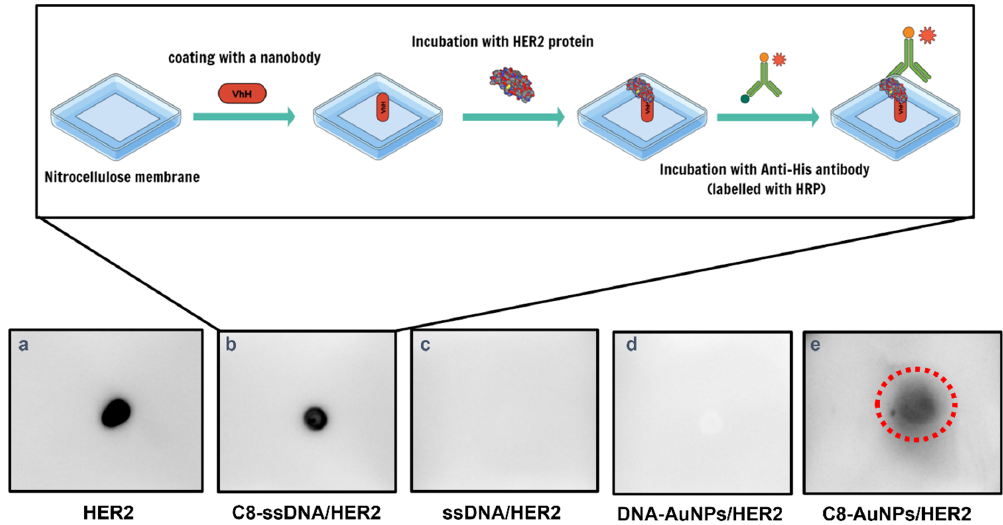
the corresponding readouts on a nitrocellulose membrane in the presence of: ( a ) HER2; ( b ) C8- ssDNA/HER2; ( c ) ssDNA/HER2; ( d ) DNA-AuNPs/HER2; ( e ) C8-AuNPs/HER2. The red circle in panel e highlights the recognition ability of the immunocomplex to